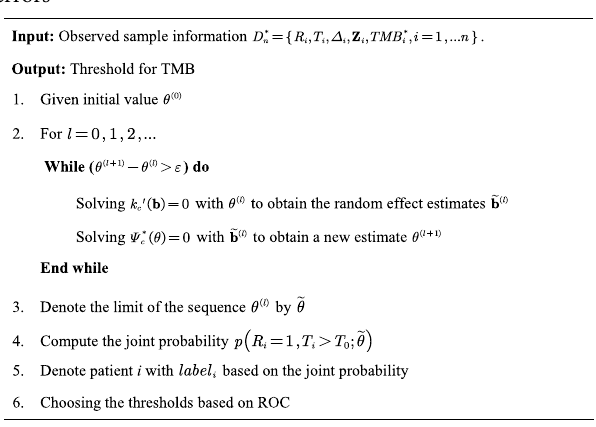
Algorithm 2. Identifying TMB threshold with measurement